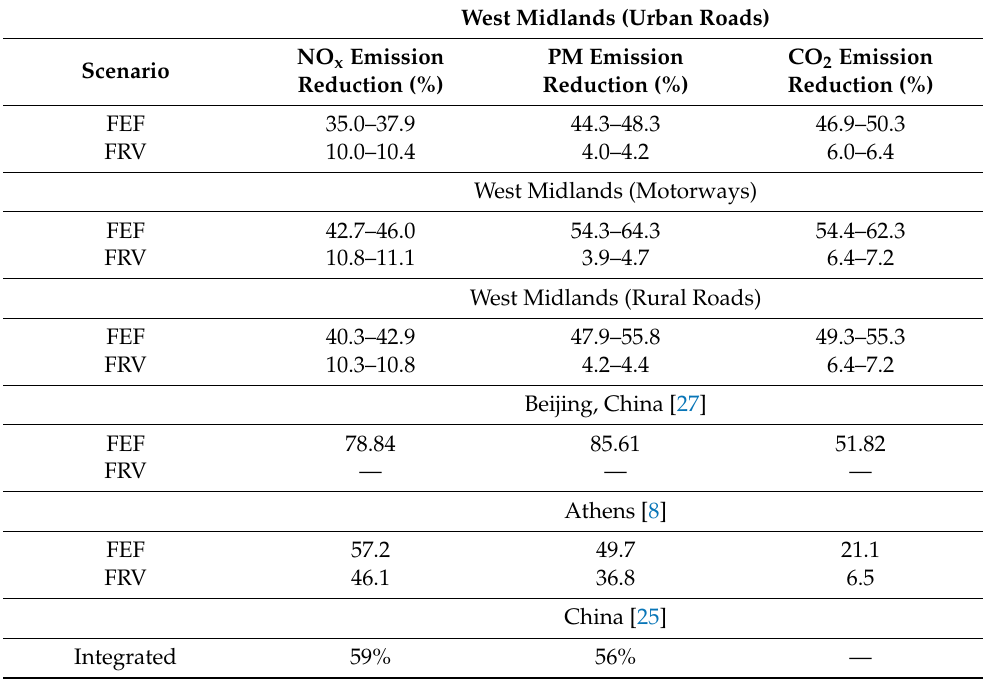
Table 5. The FEF and FRV factors in different